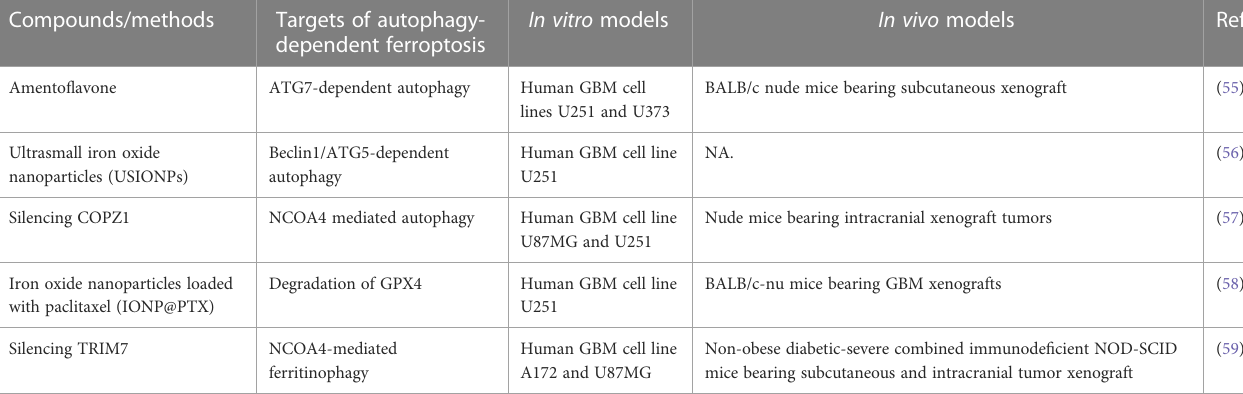
TABLE 1 In vivo or in vitro studies targeting autophagy-dependent ferroptosis in GBM.